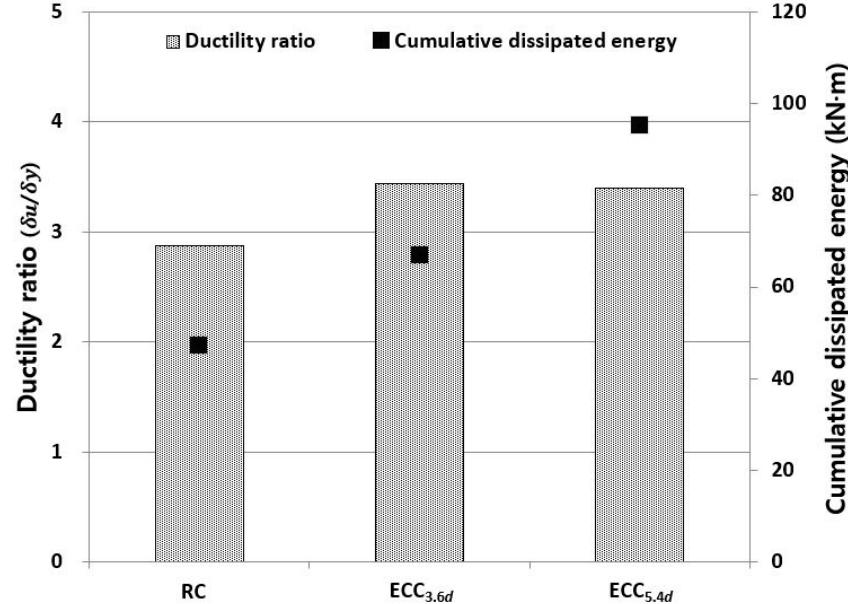
Figure 10. Ductility ratio and cumulative dissipated energy for each specimen.